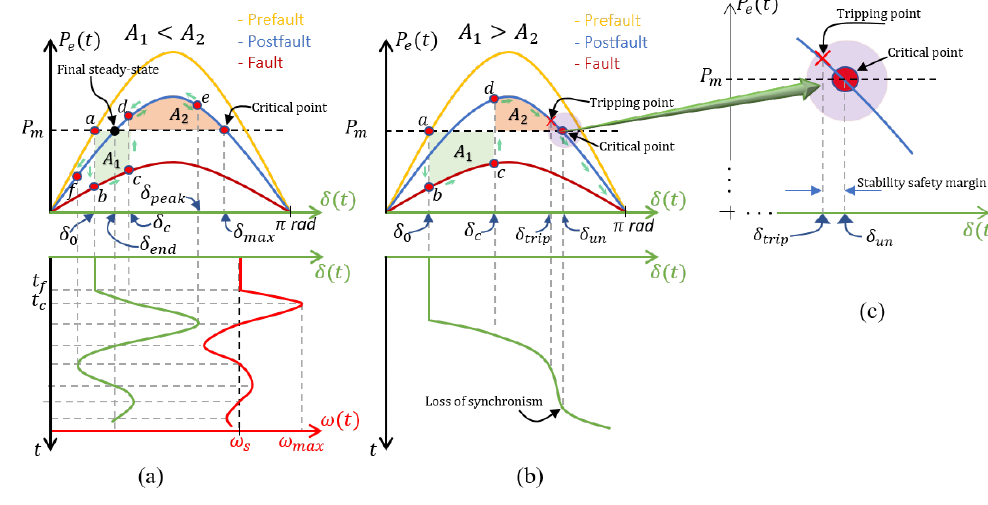
Figure 2. P − δ and δ − t curves: ( a ) stable case; ( b ) unstable case; ( c ) critical point of the unstable case.